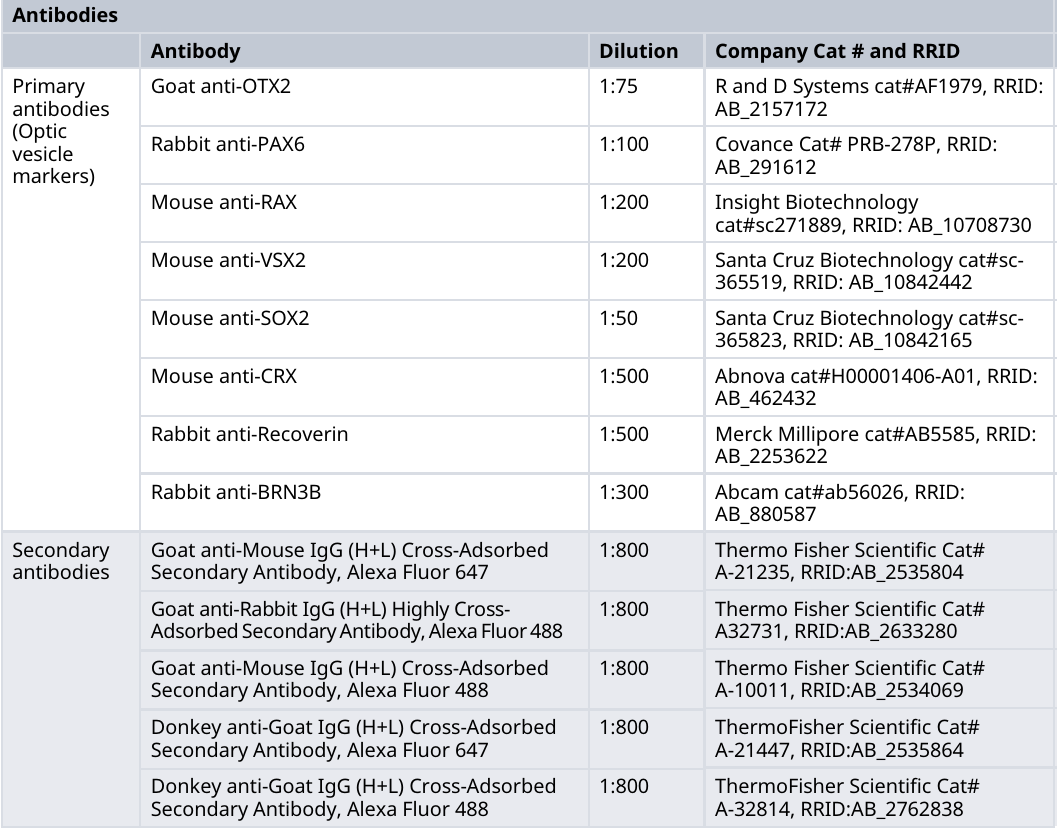
Table 2. Primary and secondary antibodies used for optic vesicle validation. Antibodies Antibody Dilution Company Cat # and RRID Primary antibodies (Optic vesicle